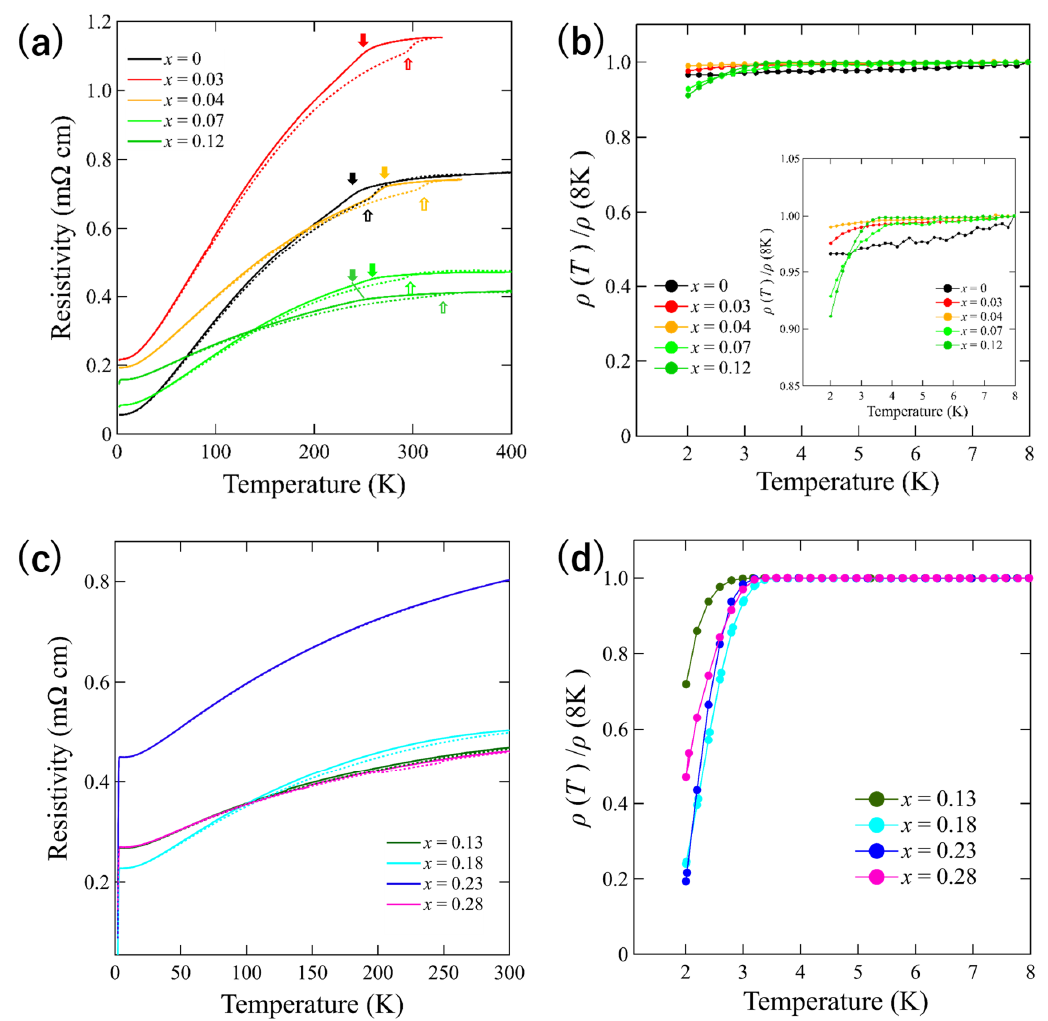
Figure 4. Temperature dependence of electrical resistivity for MoTe 2- x Se x single crystals. The results for x = 0–0.12 and x = 0.13–0.28 have been reported. ( a , c ) depict results in the entire temperature range. The solid and dotted lines correspond to the cooling and heating processes, respectively. Arrows indicate the temperature at which the kink appears ( T s ). Filled and open arrows in Figure 4a indicate T s for the heating and cooling processes, respectively. ( b , d ) illustrate the region below 8 K, normalized by the resistivity at 8 K. The inset of ( b ) represents the magnified image ( b ) near the superconducting transition.